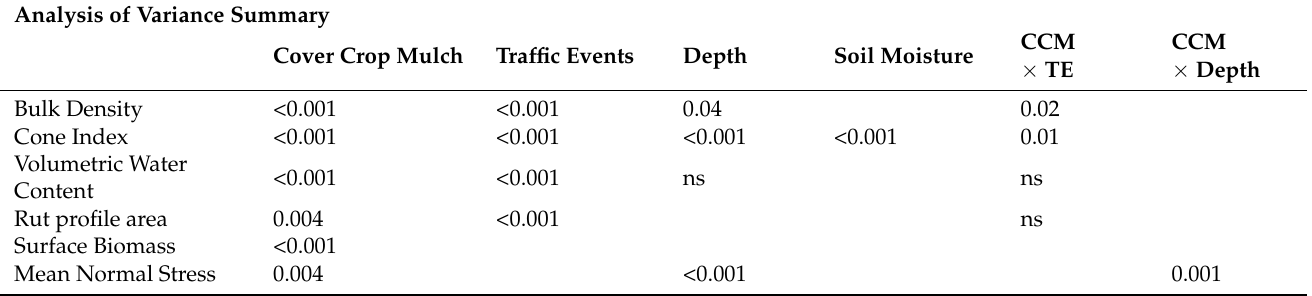
Table 2. Analysis of variance, with all soil properties and variables taken into